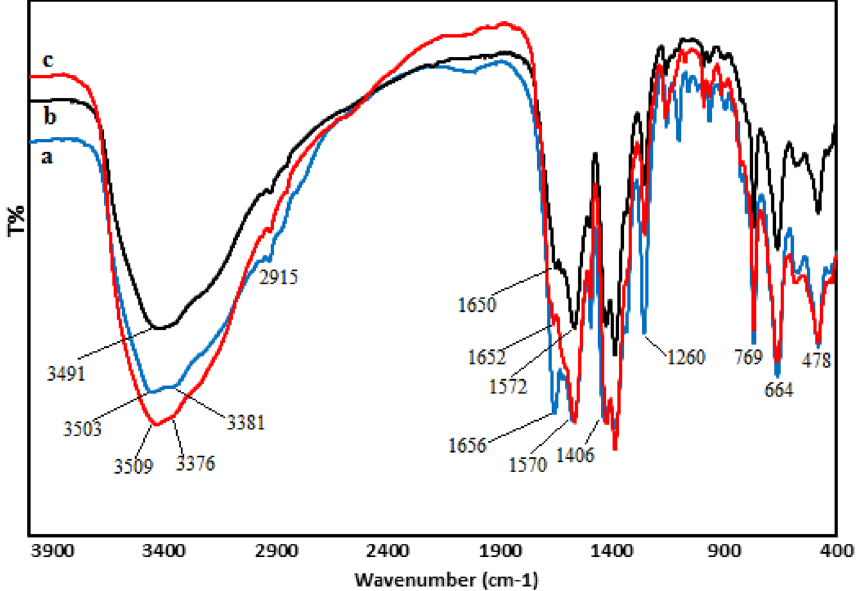
Figure 2. FT-IR spectra of UiO-66-NH 2 ( a ), UiO-66-biguanidine ( b ) and UiO-66-biguanidine/Pd ( c